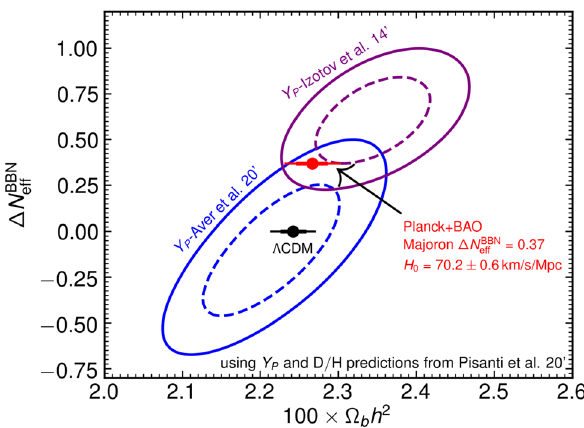
Fig. 10 BBN constraints on (cid:2) N BBN as a function of (cid:19) b h 2 . Contours eff correspondto1and2 σ CL.Wehavecalculatedthepredictionsusingthe resultsof[156],thedeuteriummeasurementsfrom[159],andperformed twoanalysesfortheheliummeasurementsof[109,110].Inredweshow the 1 and 2 σ CL posterior from our CMB analyses in Sect. 4. We can appreciate that our region of interest is in agreement within 2 σ with successful BBN irrespectively of the adopted Y P value